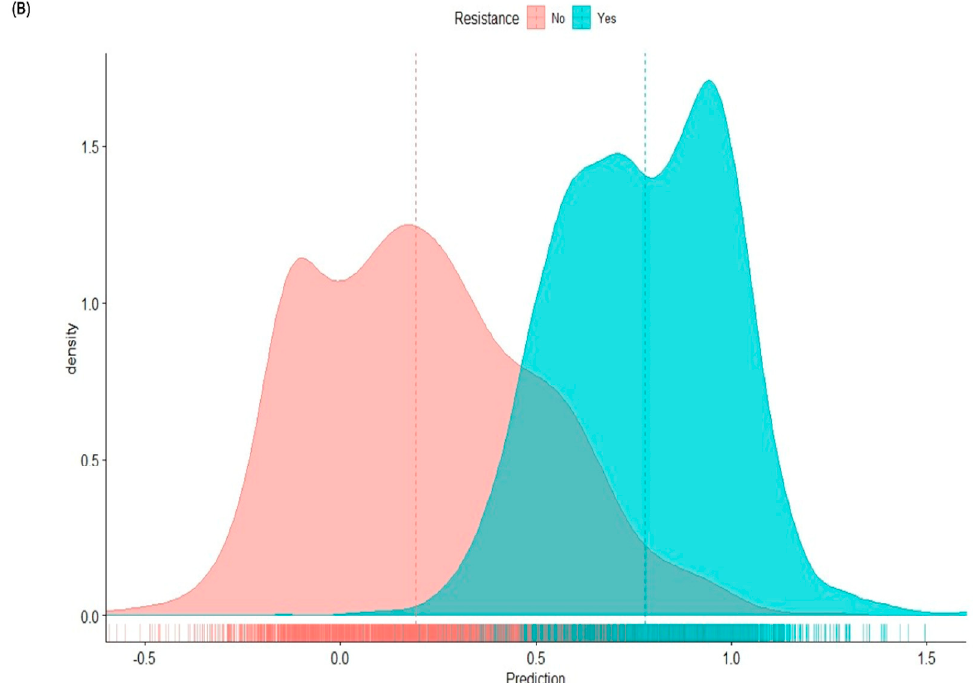
Figure 2. ( A ) Normalised NIR spectra in the 350–2500 nm region from susceptible K. pneumoniae (red line) and resistant K. pneumoniae (black line) Panel ( B ) Density plots showing NIRS differentiation of K. pneumoniae AMR-genes negative or susceptible (Pink) and AMR harbouring or resistant (Blue).